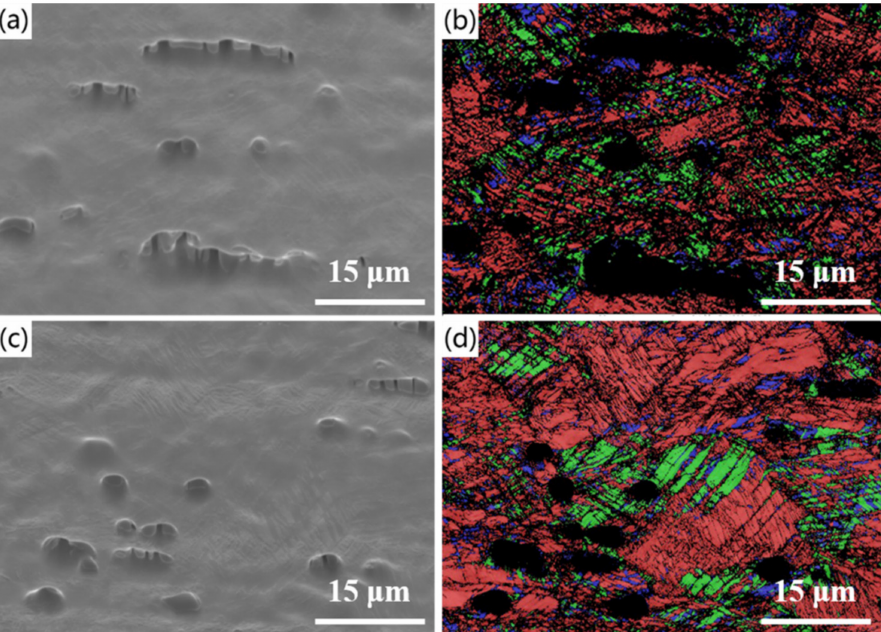
Figure 8. SEM and EBSD phase maps of 30B-600 and 30B-900 after fracture. ( a ) SEM of 30B-600; ( b ) EBSD phase map of area in ( a ); ( c ) SEM of 30B-900; ( d ) EBSD phase map of area in ( c ). In the phase maps, green = γ , blue = ε , red = α (cid:48) , black = unindexed areas/M 2 B. Rolling direction = horizontal, thickness direction =